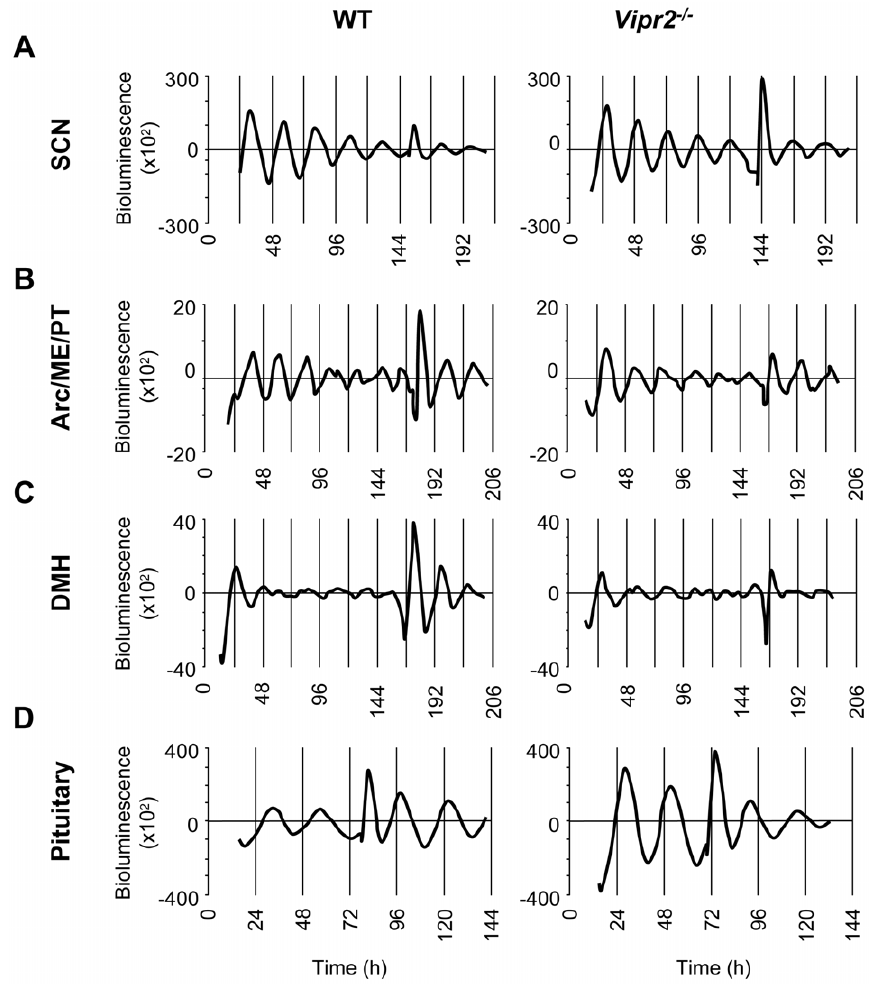
Figure 4. Rhythm Amplitude of PER2::LUC Expression in WT and Vipr2 2 / 2 SCN, MBH and Pituitary are Differentially Affected by GRP Treatment. Representative plots of detrended PER2::LUC bioluminescence expression from WT and Vipr2 2 / 2 SCN ( A ), Arc/ME/PT complex ( B ), DMH ( C ) and pituitary ( D ) cultures, prepared from mice housed under LD conditions. ( A ) GRP treatment failed to increase rhythm amplitude in both WT and Vipr2 2 / 2 SCN. ( B ) Both WT and Vipr2 2 / 2 Arc/ME/PT responded to GRP treatment with an increase in rhythm amplitude. ( C ) GRP application increased the amplitude of DMH rhythms in WT tissue but not Vipr2 2 / 2 . ( D ) WT pituitaries responded to GRP application with an increase in rhythm amplitude (though see results text and Table 2 note) while Vipr2 2 / 2 pituitaries failed to do so. Traces for WT SCN, Arc/ME/PT and pituitary are plotted as circadian time while all other tissues are plotted as time from culture preparation. Note treatment artefacts immediately after GRP application to